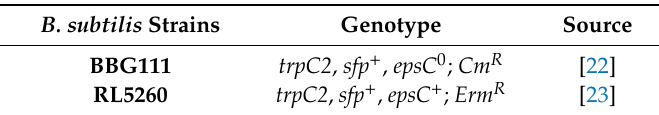
Table 1. Strains used in this study.